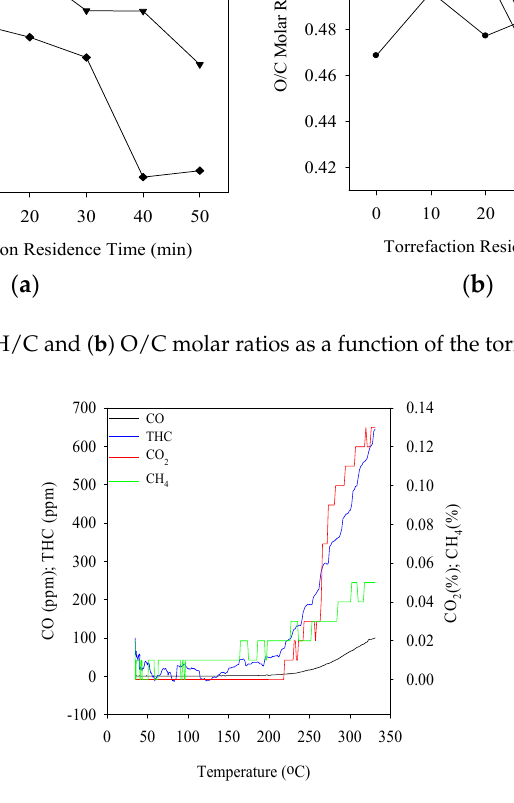
Figure 7. Gas analysis from torrefaction of sewage sludge as a function of the temperature.